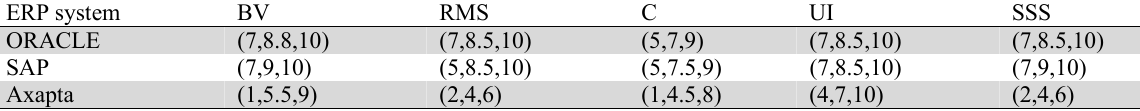
Fuzzy decision matrix for ERP system selection problem for example 2